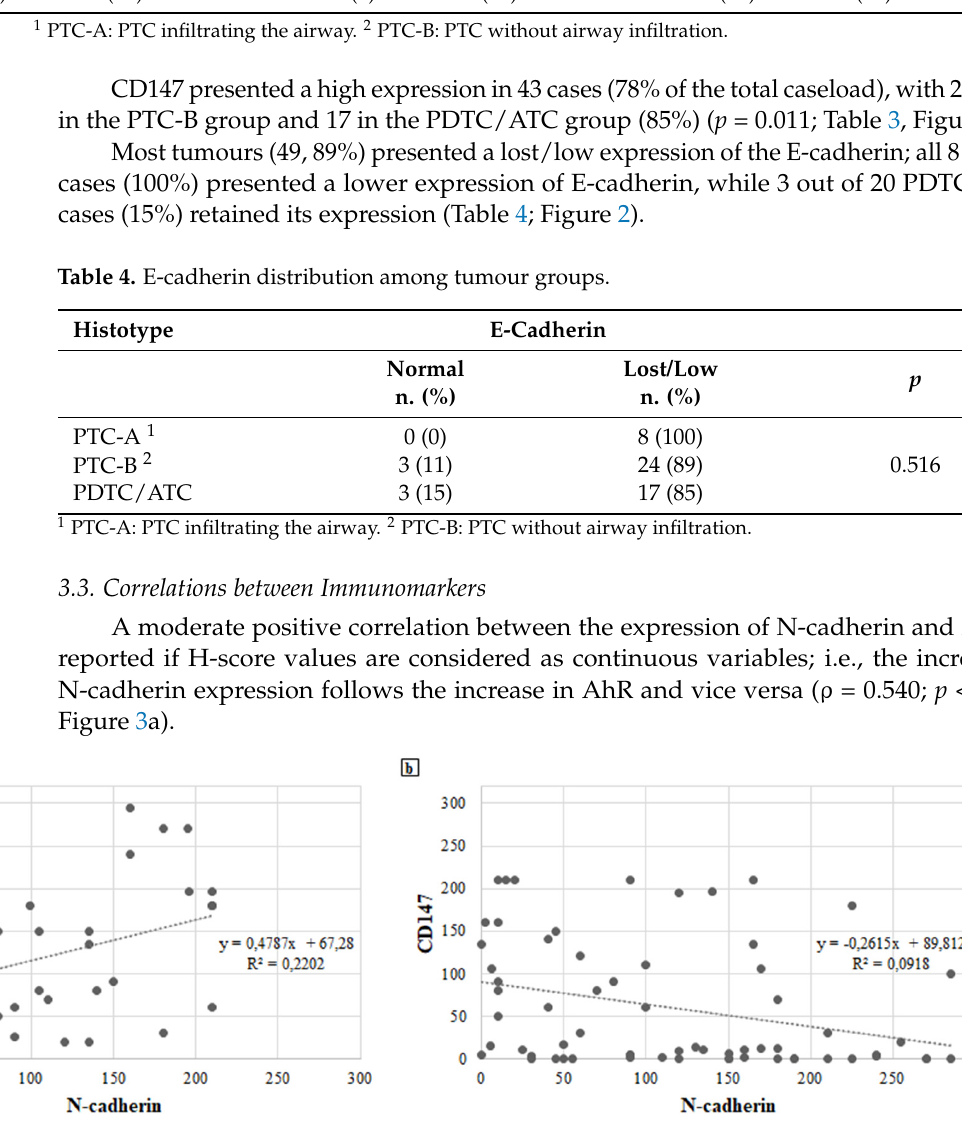
Figure 3. ( a ) Positive relationship between the expression of N-cadherin and AhR. ( b ) Negative relationship between the expression of N-cadherin and CD147.